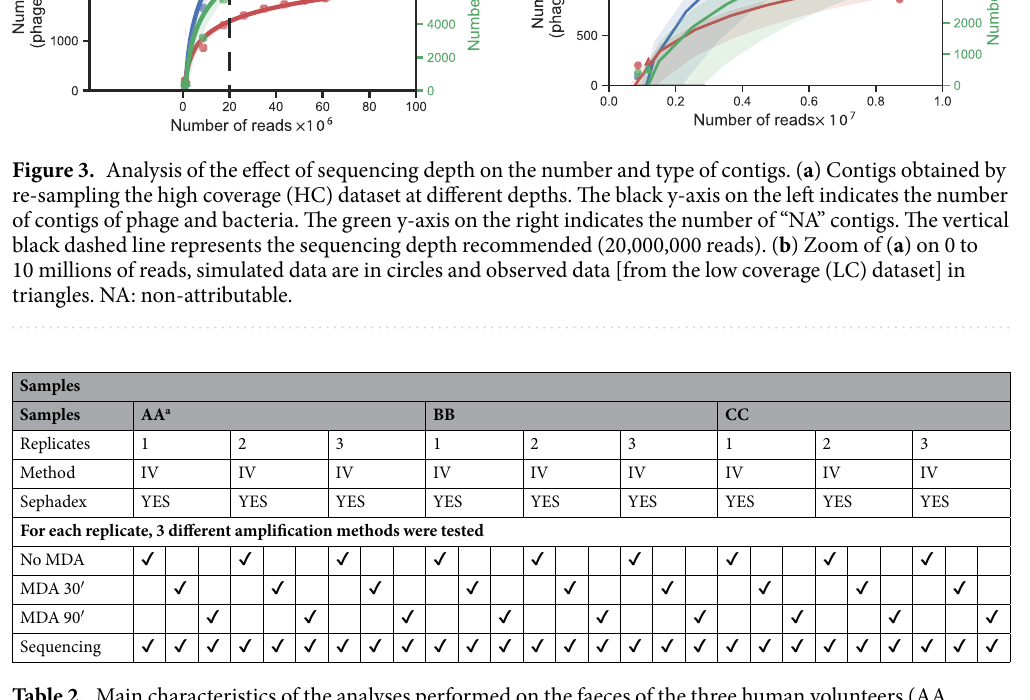
Table 2. Main characteristics of the analyses performed on the faeces of the three human volunteers (AA, BB, CC) for assessing the reproducibility of the method IV and the effects of MDA. a The AA and AA 0 (see in Table 1) faecal samples correspond to two different faecal samples from the same individual. Abbreviations: MDA-Multiple displacement